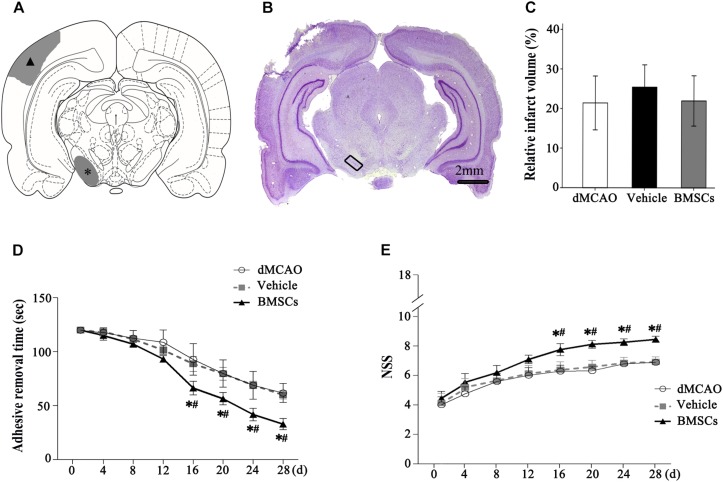
Relative infarct volume and neurological functional evaluations with or without BMSCs transplantation after dMCAO in rats. (A) Schematic diagram of cortical infarction (marked with arrowhead) and ipsilateral SN (marked with asterisk). (B) Nissl-stained coronal brain sections of focal cortical infarction at 4 weeks after dMCAO. The infarcted tissue appeared white, while the intact tissue is colored. The ipsilateral SN was marked with quadrangle. (C) Quantitative analyses of relative infarct volume at 4 weeks after dMCAO. There was no significant difference in the relative infarct volume among dMCAO, vehicle and BMSCs groups [F(2, 18) = 0.478, p > 0.05]. (D) Adhesive removal test at 1–4 weeks after cortical infarction. Quantitative analyses showed that transplantation of BMSCs reduced the mean time to remove the adhesive from the forepaws after dMCAO [F(2,
19) 16
d = 16.87, p < 0.01; F(2, 19) 20
d = 19.76, p < 0.01; F(2, 19) 24
d = 30.14, p < 0.01; F(2, 22)
28
d = 52.75, p < 0.01]. (E) NSS at 1–4 weeks after dMCAO. Quantitative analyses showed that transplantation of BMSCs raised NSS after dMCAO [F(2, 19)
16
d = 22.08, p < 0.01; F(2, 19) 20
d = 54.54, p < 0.01; F(2, 19) 24
d = 60.91, p < 0.01; F(2, 18)
28
d = 79.67, p < 0.01]. *p < 0.05 vs. dMCAO groups, #p < 0.05 vs. vehicle groups (n = 7 in each group). dMCAO, distal middle cerebral artery occlusion; BMSCs, bone marrow stromal cells; NSS, neurological severity score; d, day.